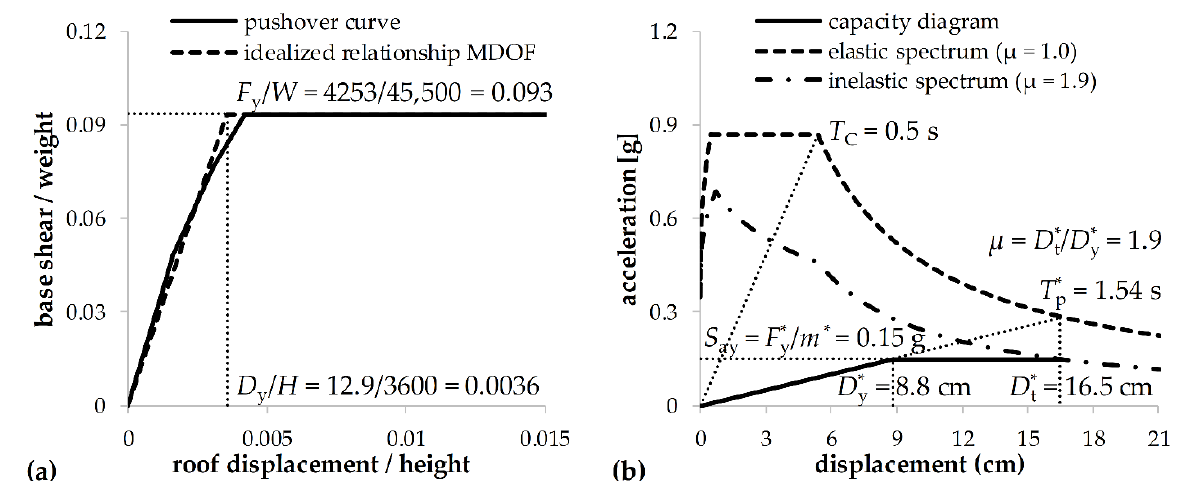
Figure 3. Results of the N2 method: ( a ) calculated and idealized pushover curves (MDOF system) and ( b ) capacity diagram, demand spectrum and displacement demand (SDOF system).